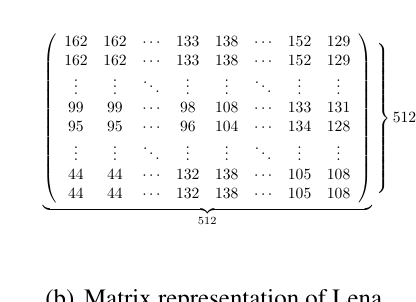
(b) Matrix representation of Lena Figure 7. Example of gray-scale Figure 7. Example of gray-scale figure